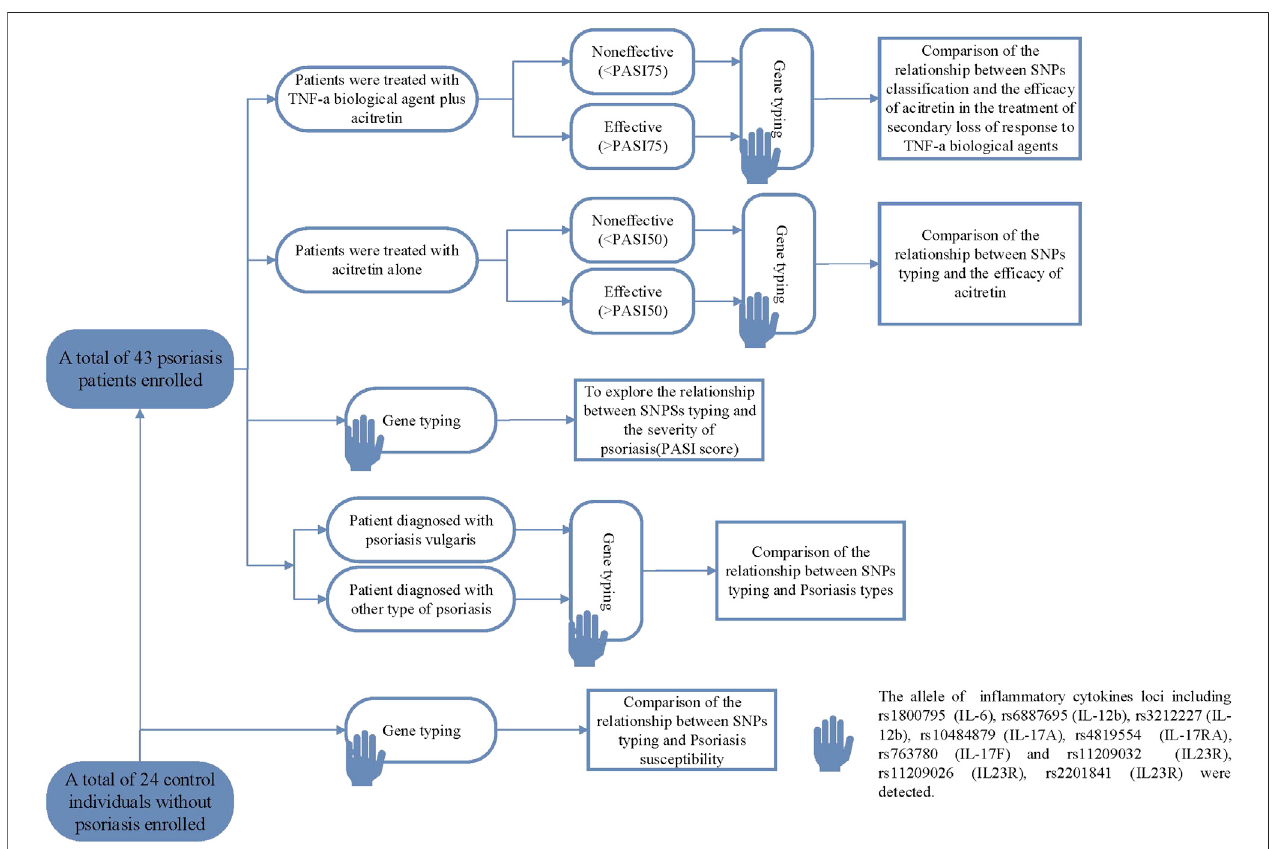
FIGURE 1 | The fl owchart of clinical trials and analysis in this